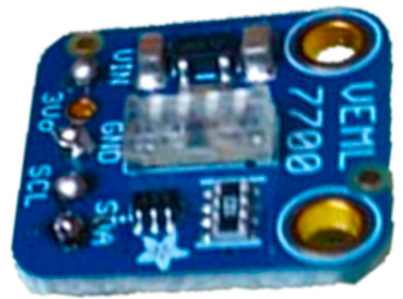
Figure 11. Illuminance sensor VEML7700.